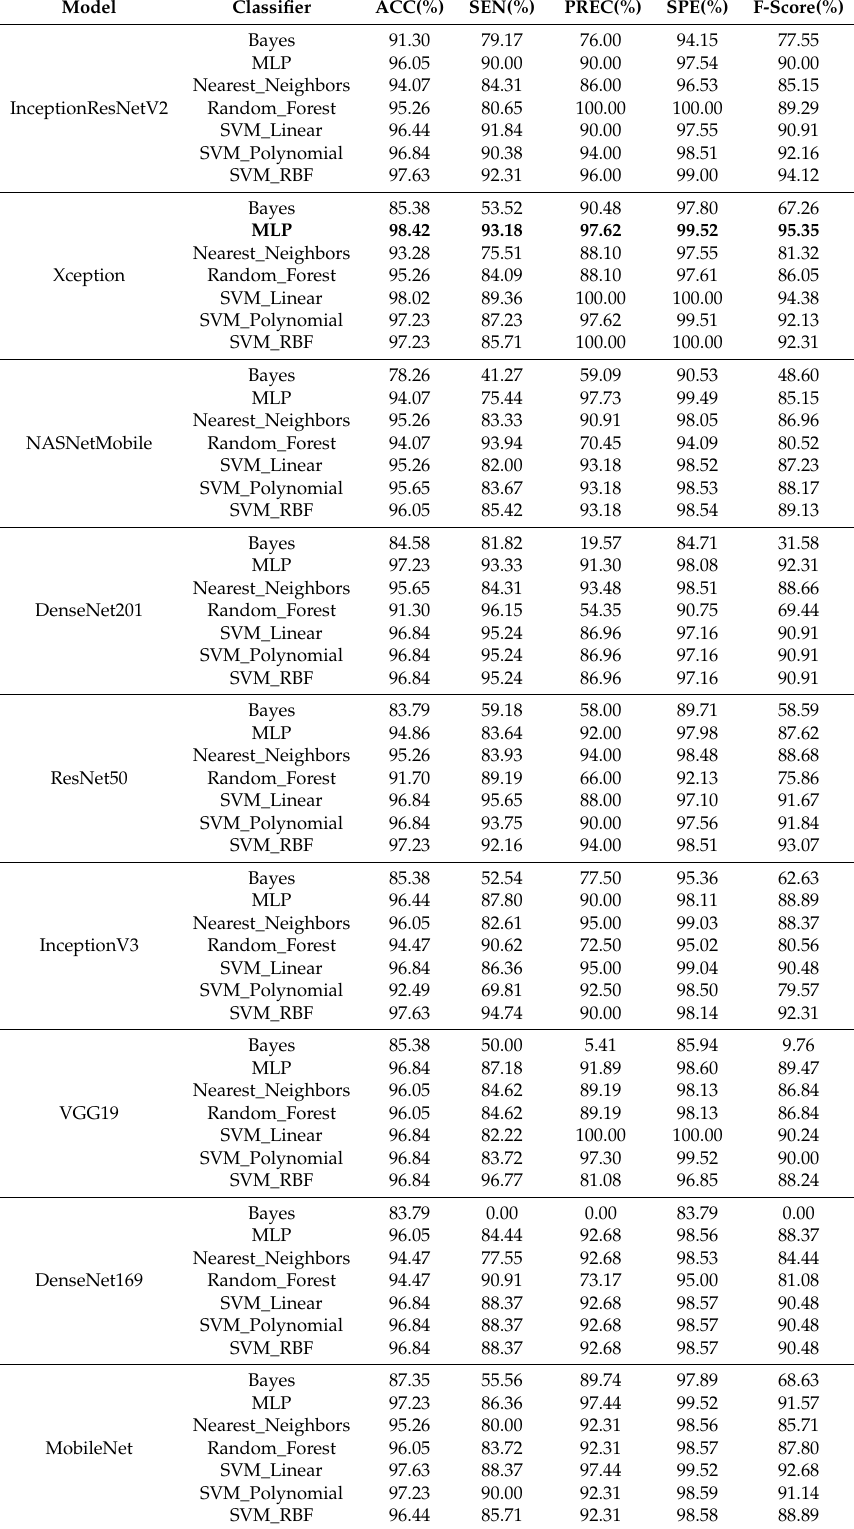
Table 1. The Table presents results of the combinations between deep attribute extractors and the classifiers in the test set after training for the classification of CT images in lung or non-lung. The metrics used to validate the first stage of our approach were Accuracy (ACC), Sensitivity (SEN), Precision (PREC), Specificity (SPE) and F1-Score. In all, 253 images representing the test set were